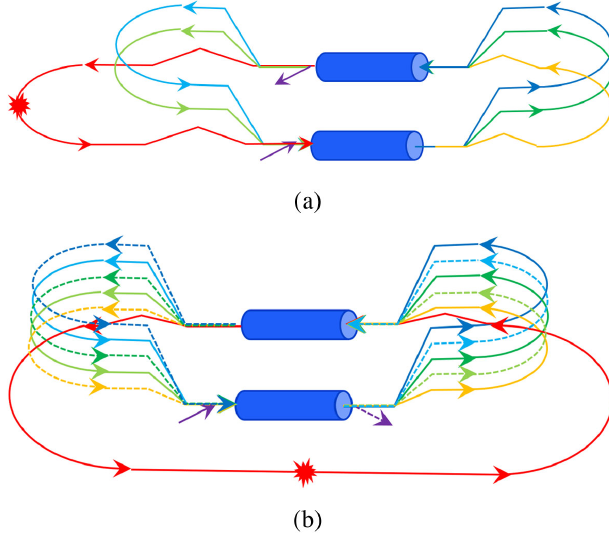
FIG. 1. Simplest racetrack ERL configurations, blue cylinders represent the linacs, and the spiked ball represents the interaction region. (a) common transport and (b) separate transport, with solid and dashed lines indicating the arcs traversed during acceleration and deceleration